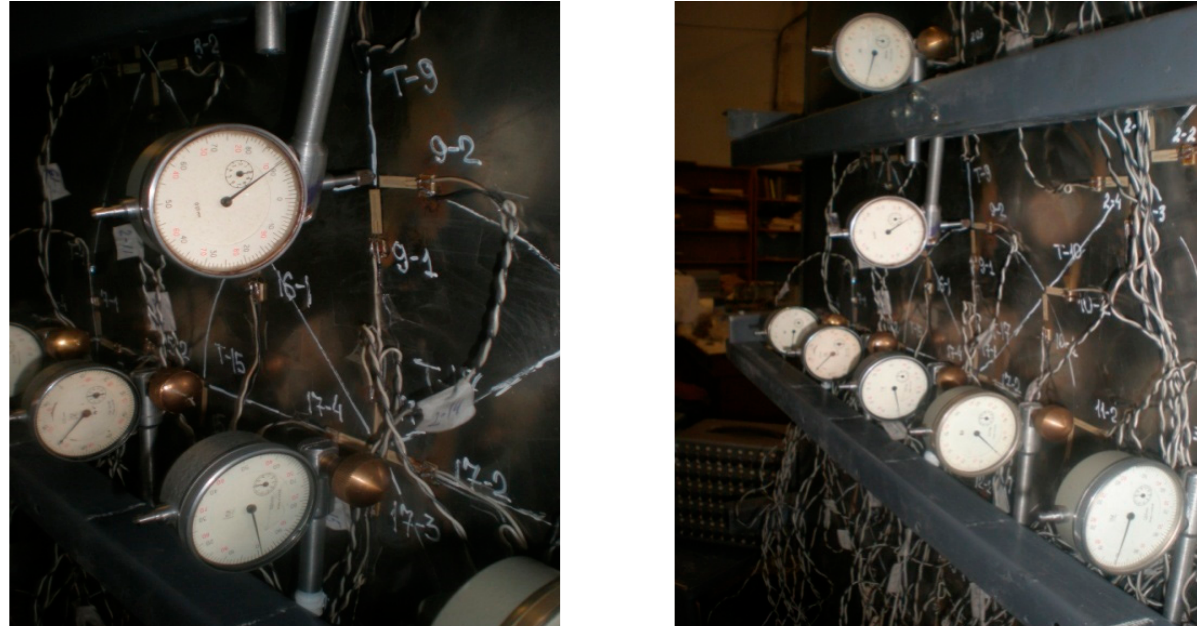
Figure 4. Ich ‐ 04 displacement indicators, fixed on special brackets. Figure 4. Ich-04 displacement indicators, fixed on special